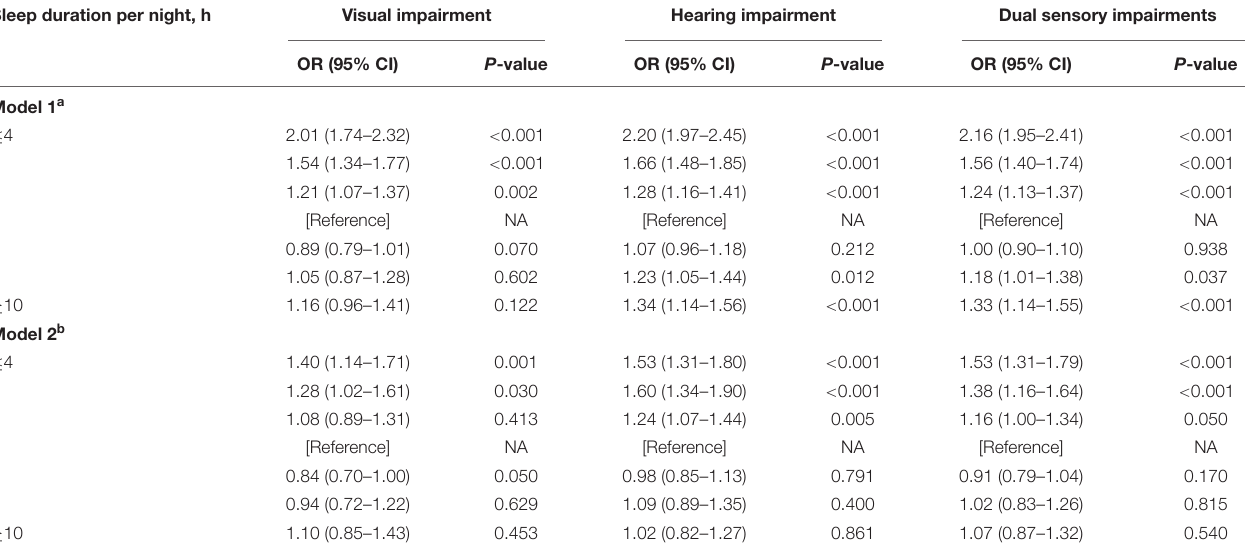
TABLE 2 | Associations between sleep duration and sensory impairments in participants from the 2018 China Health and Retirement Longitudinal Study. Sleep duration per night, h